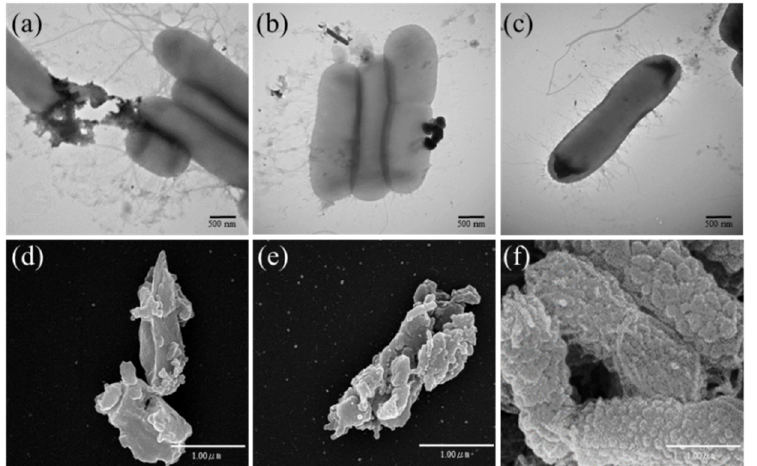
Figure 10. TEM ( a – c ) and SEM ( d – f ) images of E. coli with and without treatment with AgNPs (20 µg/mL). The E. coli cells were treated with ( a , d ) A-BG-AgNPs and ( b , e ) E-BG-AgNPs, and ( c , f ) show untreated bacteria cells.